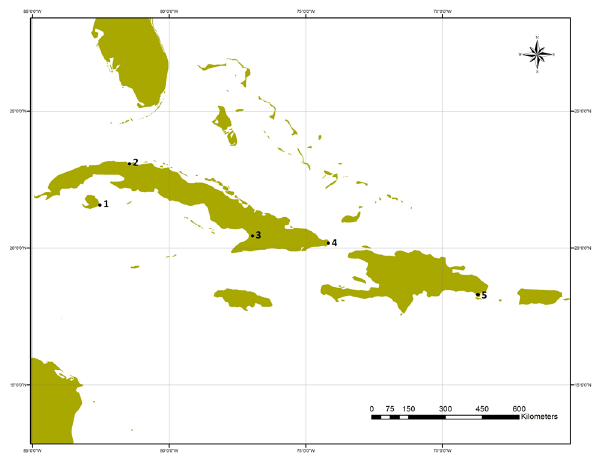
Figure 1: Location of the archaeological sites included in this study: ( 1 ) Cueva No. 1 de Punta del Este, Cuba; ( 2 ) Canímar Abajo, Matanzas, Cuba; ( 3 ) Playa del Mango, Granma, Cuba; ( 4 ) Los Cayucos, Guantánamo, Cuba; and ( 5 ) Cueva de José María, Altagracia, the Dominican